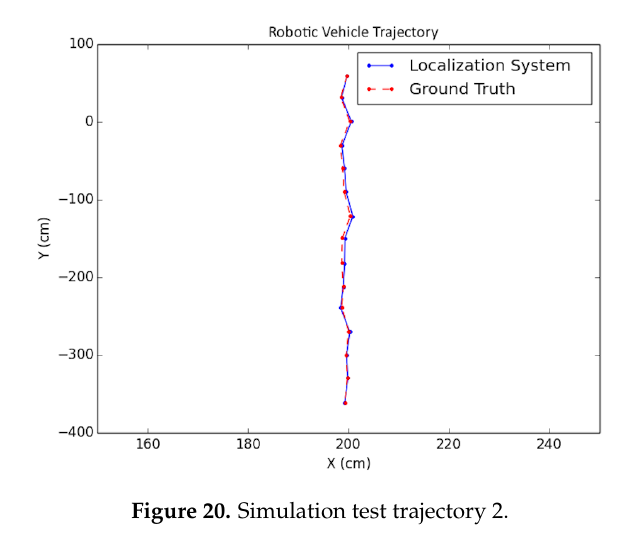
Figure 20. Simulation test trajectory 2.